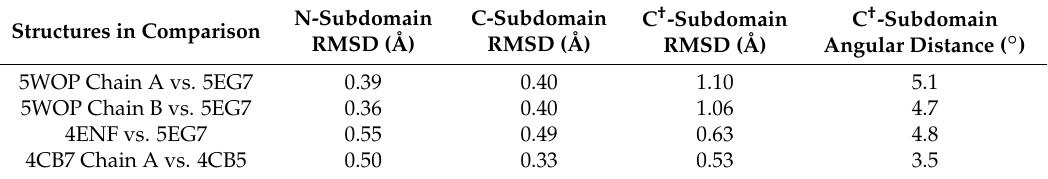
Table 2. Alternative superposition of PB2cap structures and their subdomains